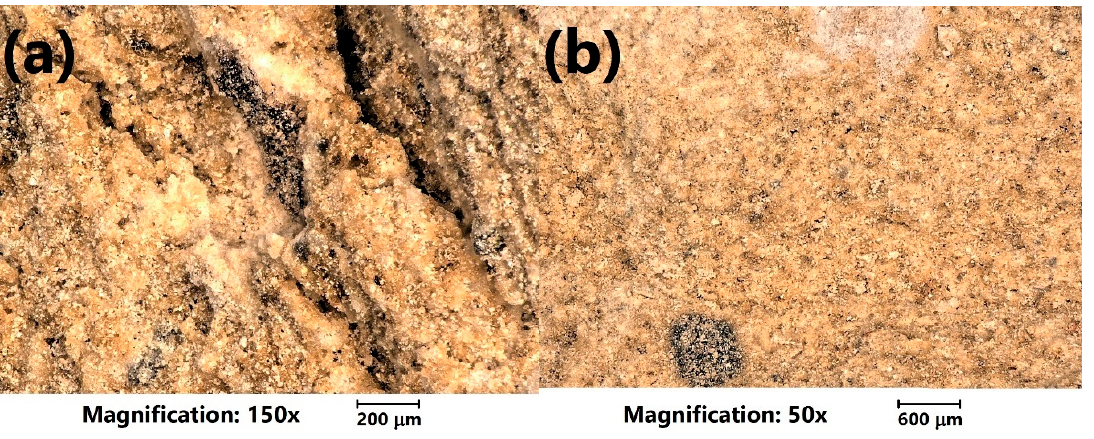
Figure 5. Images of the ( a ) C 30 SS 50 and ( b ) C 50 SS 30 LWAs’ surfaces obtained with an optical microscope at higher magnifications.